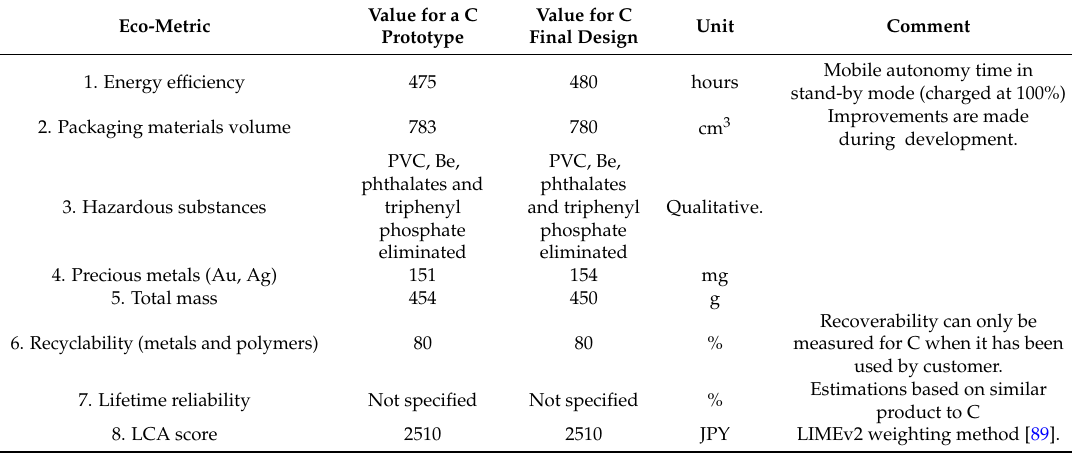
Table 2. Eco-metric values for a Prototype of C and Final design of C in Design Step 4.3.